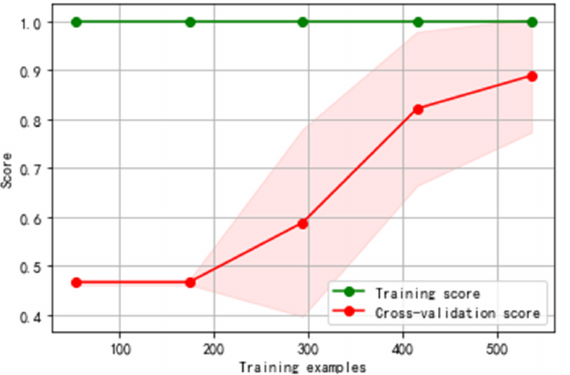
Figure 7. Learning Curve.